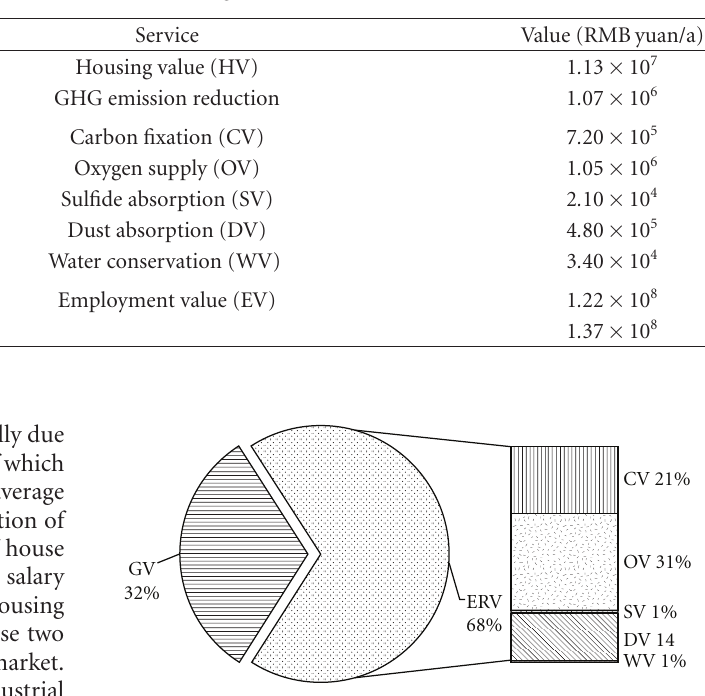
Table 2: The economic value of each ecological service.